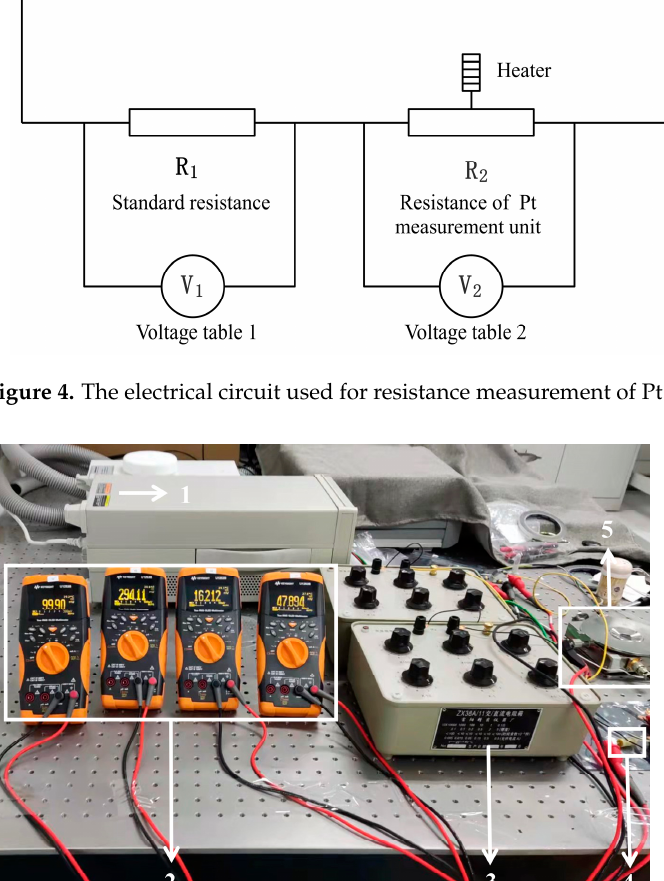
Figure 5. The layout of a test bench for electrical measurement. (1—direct current power supply, 2—voltmeter, 3—variable resistance box, 4—fixed resistance, 5—vacuum cavity).